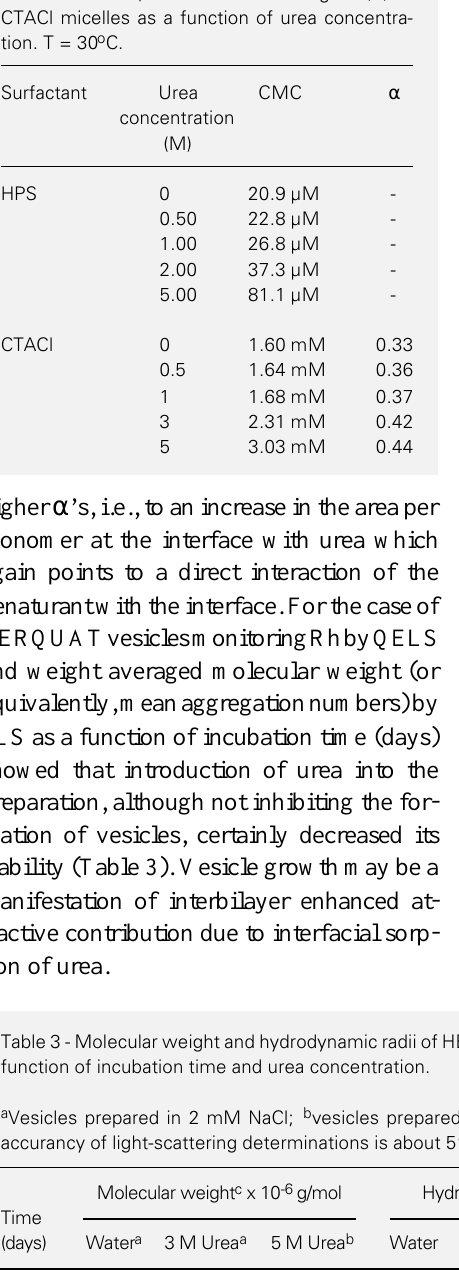
Table 2 - Critical micellar concentrations (CMC) of HPS and CTACI, and dissociation degree ( a ) of